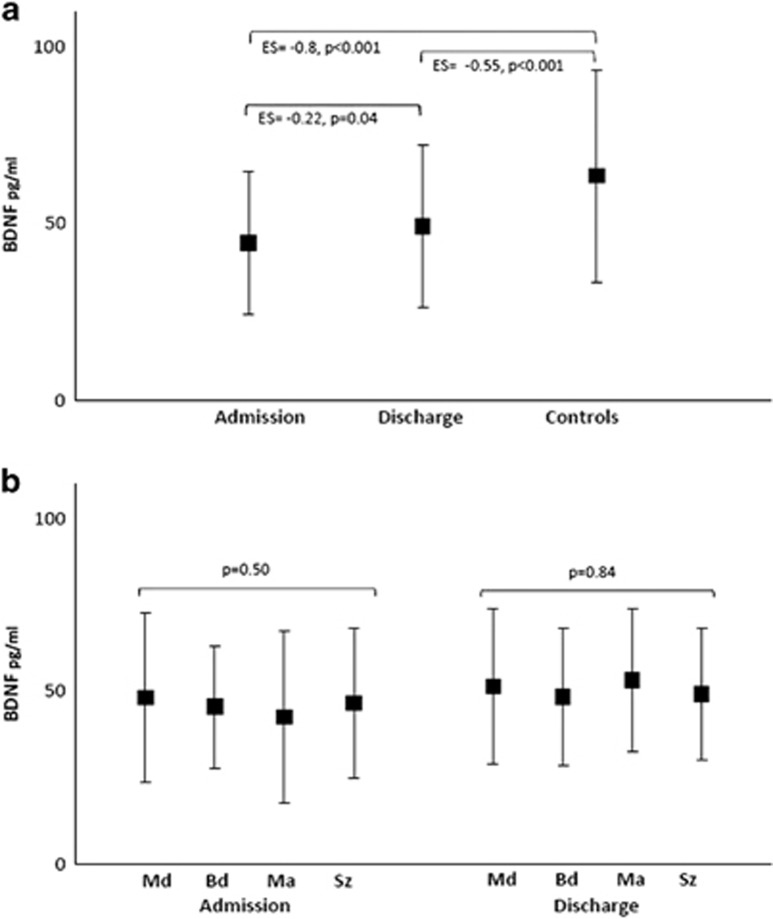
The mean BDNF serum levels in (a) SMI patient total sample in admission and upon discharge and in healthy controls and (b) in SMI patients subdivided by diagnosis in admission and upon discharge. (a) In admission time point, SMI patients' BDNF serum level has a large difference when compared with controls (ES: −0.80; 95% CI: −1.05, −0.56). It increases during the inpatient treatment and remains moderately reduced at discharge when compared with controls (ES: −0.55; 95% CI: −0.81, −0.29). (b) BDNF levels among diagnoses are similar in both moments of the treatment. BDNF, brain-derived neurotrophic factor; Bd, bipolar depression; CI, confidence interval; ES, effect size; Ma, mania; Md, major depression; SMI, severe mental illness; Sz, schizophrenia.